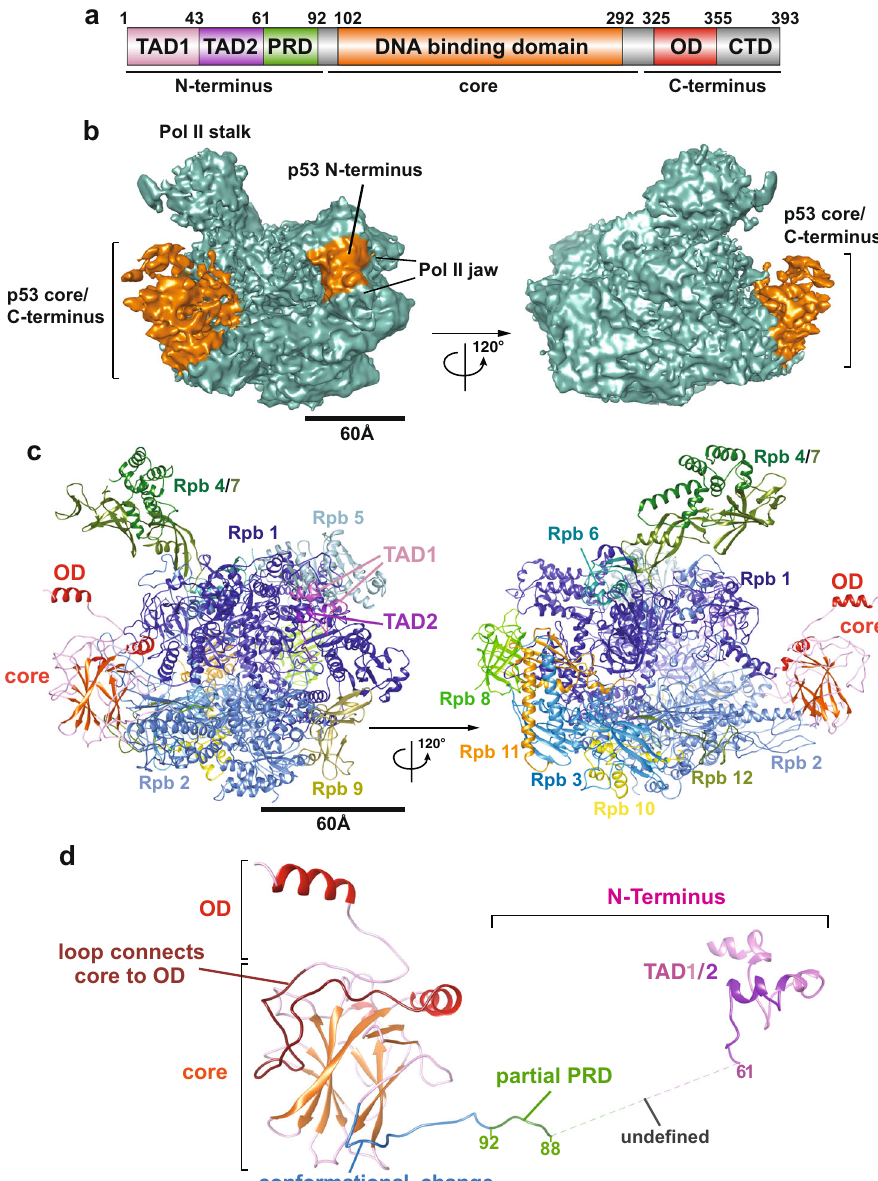
Fig. 1 3D reconstruction and molecular structure of the p53/Pol II co-complex. a Schematic representation of the domain structure of p53. Delineation of the transcription activation domains (TADs, pink/lilac), proline-rich domain (PRD, green), DNA binding domain (core domain, orange), oligomerization domain (OD, red), and C-terminal regulatory domain (CTD, gray) are presented. b 3D reconstruction of p53/Pol II is shown in two different views. The cryo-EM density representing the p53 protein is highlighted in orange. The Pol II density is colored teal with two canonical structural features indicated. The scale bar represents 60 Å. c Two different views of the p53/Pol II molecular structure are shown. Key functional domains of p53 and Pol II ’ s subunits are indicated and color-coded. d Overall molecular structure of the p53 protein with main domain features as indicated is shown. A portion of proline-rich domain (PRD, 62-88 aa) is unresolved (due to insuf fi cient cryo-EM densities), which is presented as a gray dash line that connects TADs and PRD/core domain. The N-terminal region of the p53 core domain (94-109 aa, blue loop) undergoes a conformational change compared to the previous core domain crystal structure (PDB 3TS8) 34